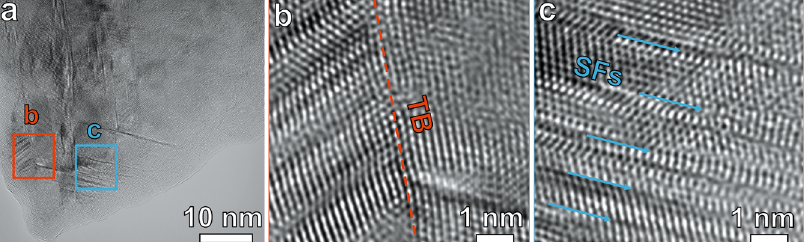
Fig. 4 TEM images showing the deformation microstructures of the CCS after the in situ tensile test. a Twins and stacking faults near the cracked regions. b Zoom-in image showing the twinning. c Zoom-in image showing the stacking faults. “ TB ” and “ SFs ” indicate the twin boundary and stacking faults,